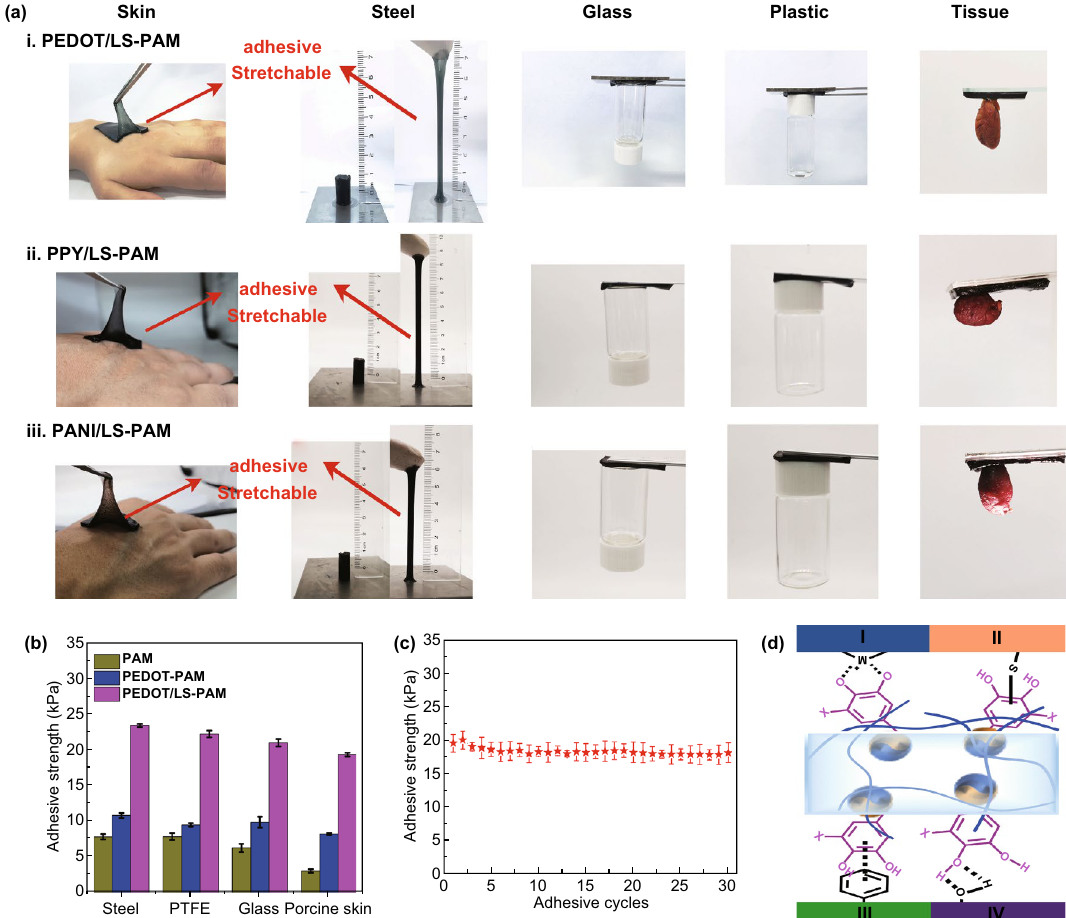
Fig. 3 Adhesion of the CP/LS NPs-incorporated hydrogels. a CP/LS-PAM hydrogel adhered to skin of hand and steels and was stretched with a large strain; the hydrogel can also adhere to glass, plastic, and fresh tissue from SD rat. b Adhesive strength of PEDOT/LS-PAM hydrogel to dif- ferent substrates. c Repeatable and long-term adhesive strength of the PEDOT/LS-PAM hydrogel. (The ratio of EDOT/LS is 2:1, and the content of PEDOT/LS is 3wt ‰.) d Interactions between the hydrogel and various substrates; I. coordination bond. II. Covalent linking. III. π–π interac- tion. IV. Hydrogen